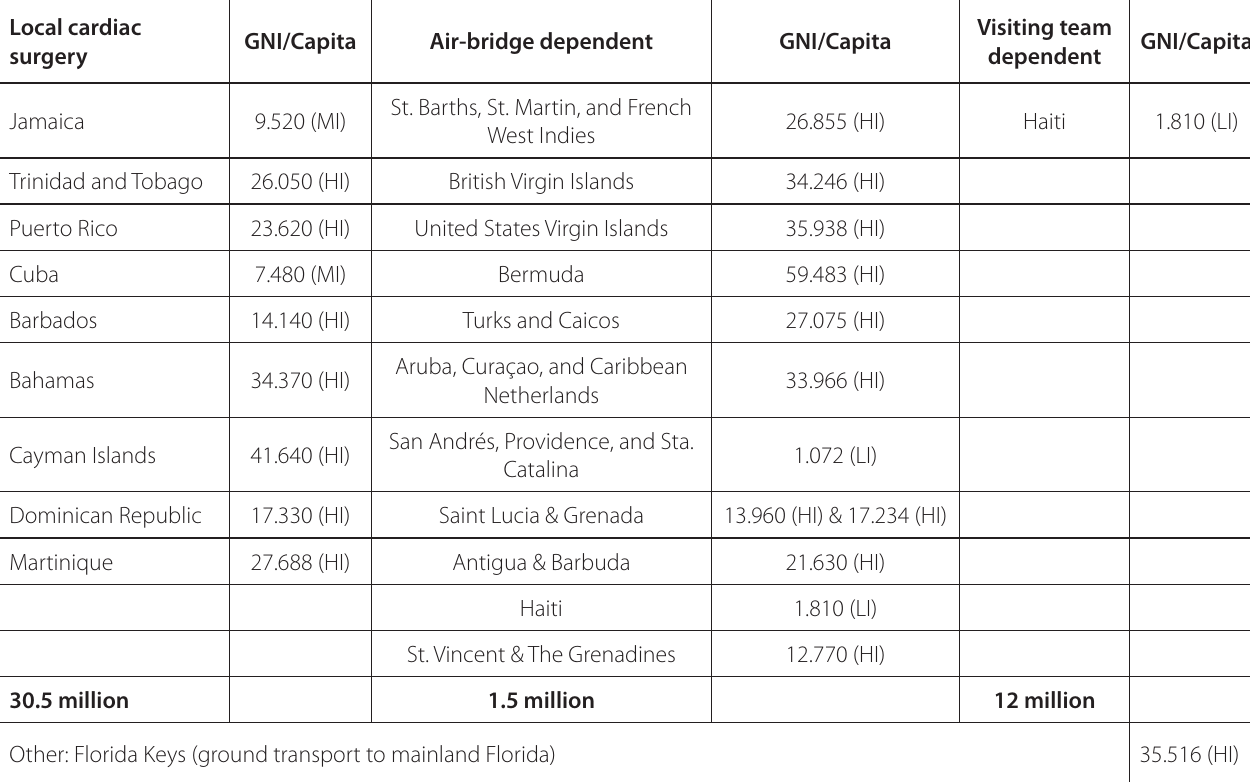
Table 2 . Caribbean islands with cardiac surgery centers, visiting teams, and air-bridge dependencies [1] . Local